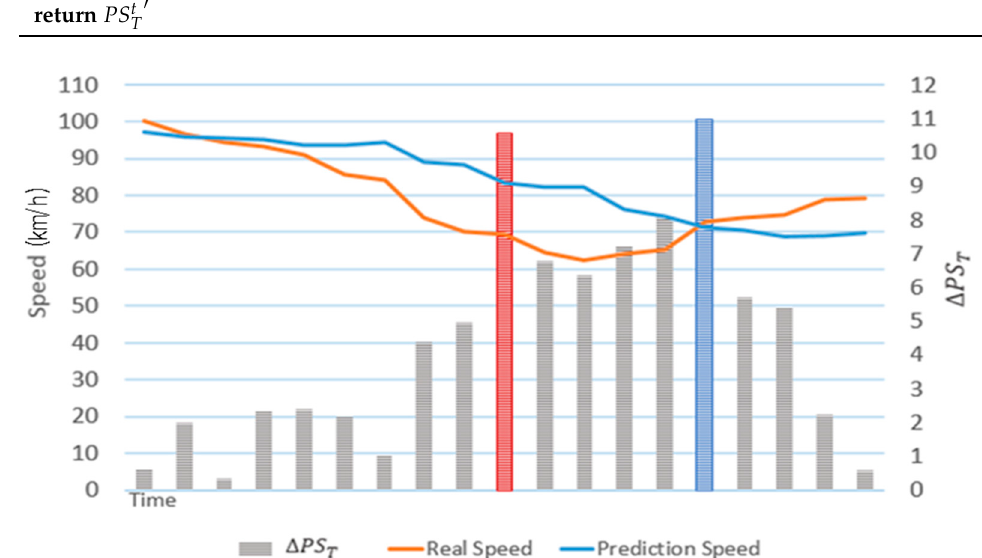
Figure 10. Relationship between the predicted speed change and actual speed.